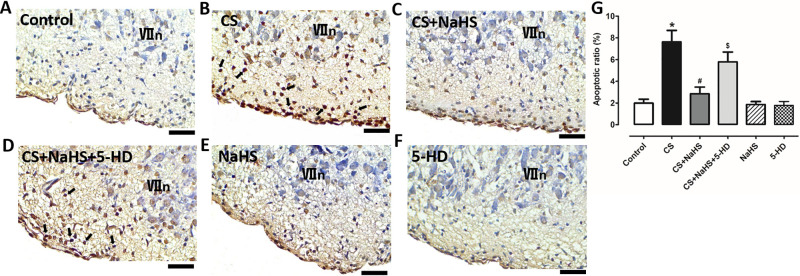
MitoKATP channel blocker inhibits the protective effect of NaHS on maternal CS exposure-induced cell apoptosis in offspring pFRG.Representative images of cellular TUNEL staining in pFRG of neonatal rats from (A) Control group, (B) CS group, (C) CS+NaHS group, (D) CS+NaHS+5-HD group, (E) NaHS group, and (F) 5-HD group; (G) comparison of apoptotic ratios in pFRG of neonatal rats among all groups. *P<0.05 vs. Control group; #P<0.05 vs. CS group; $P<0.05 vs. CS+NaHS. n = 5. Black arrows show representative apoptotic cells. Scale bars represent 20μm. VIIn: facial nucleus.